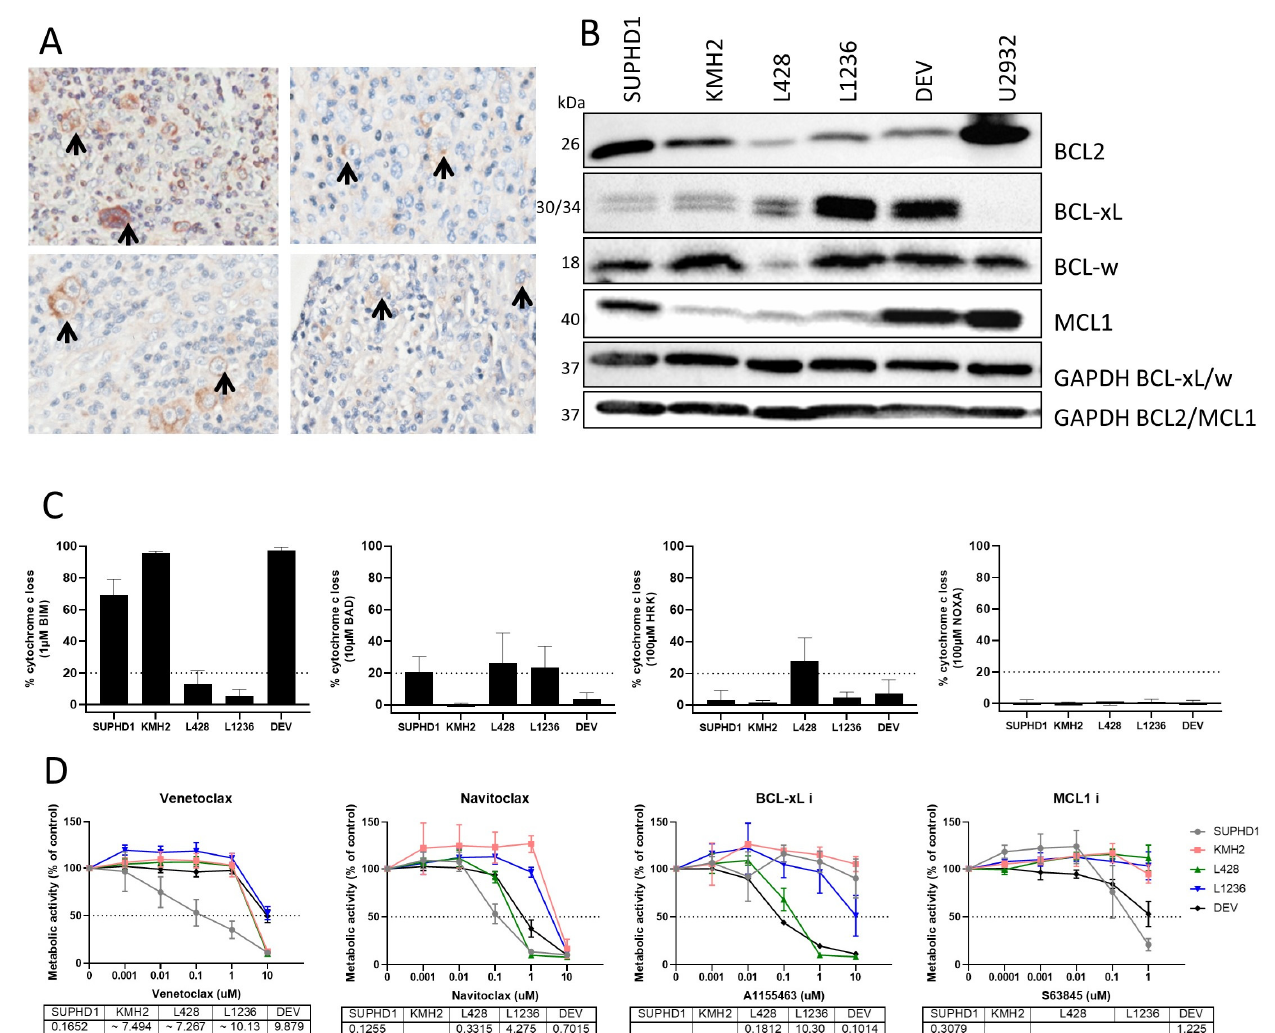
Figure 1. Anti-apoptotic proteins in Hodgkin lymphoma. ( A ). Immunohistochemistry for BCL-2 (top left), BCL-XL (top right), BCL-W (bottom left) and MCL-1 (bottom right) on HL cases. ( B ). West- ern blot of HL cell lines for BCL-2, BCL-XL, BCL-W and MCL-1. ( C ). BH3 profiles for HL cell lines for 1 µM BIM, 10 µM BAD, 100 µM HRK and 100 µM NOXA. ( D ). BH3 mimetics sensitivity for HL cell lines for venetoclax (BCL-2i), navitoclax (BCL-2/XL/Wi), A1155463 (BCL-XLi), and S63845 (MCL-1i). Sensitivity is measured by metabolic activity and normalized to untreated cells, IC50 val- ues are given in µM if possible to calculate.